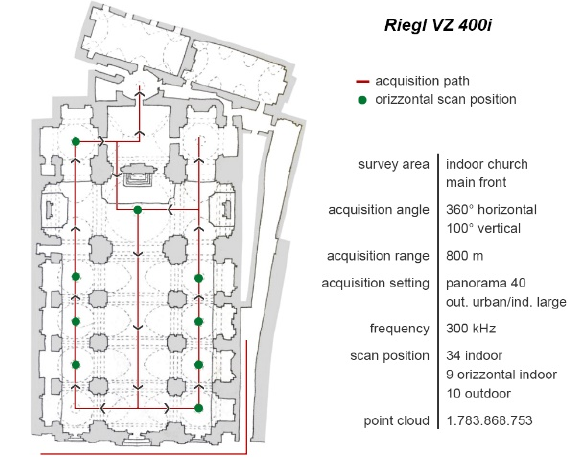
Figure 3. Range-based survey with TOF: route scheme and characteristics of the